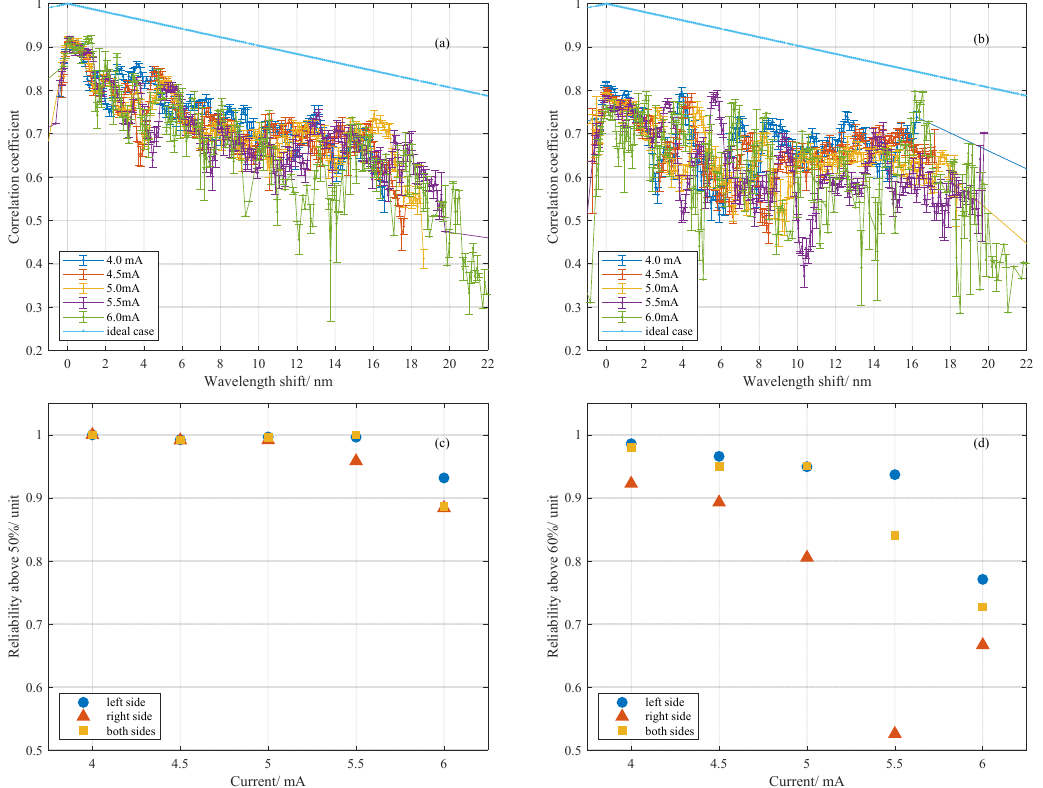
Figure 9. Statistical analysis of the coefficient versus wavelength shift and percentage of coefficient versus current: ( a ) coefficient versus wavelength shift at left-hand side; ( b ) coefficient versus wavelength shift at right-hand side; ( c ) percentage of coefficient of wavelength shift above 50% for different currents; ( d ) percentage of coefficient of wavelength shift above 60% for different currents.